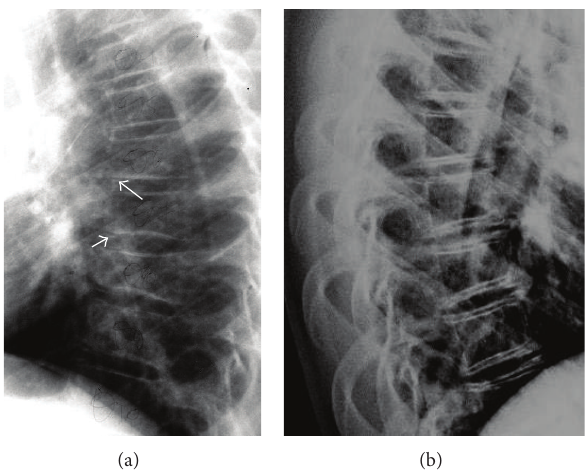
Figure 1: Lateral radiographs of the thoracic spine: (a) three months, (b) two years after bisphosphonate treatment ceased. In (a) there was osteopenic appearance, decreased height, and mild end-plate sclerosis of the thoracic vertebral bodies, whereas faint ossifications of the anterior endplates were seen (arrows). In (b) a typical “bone in bone” appearance of thoracic vertebral bodies was apparent.